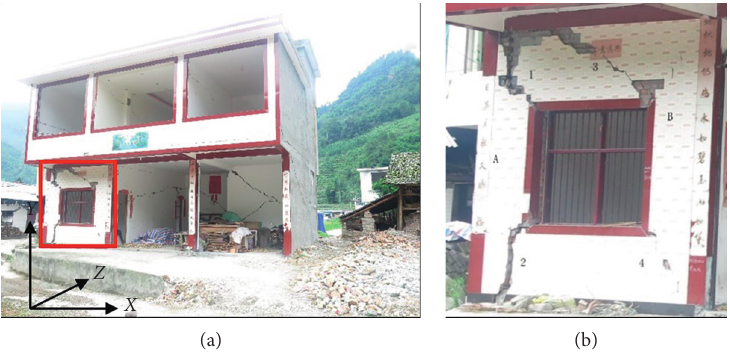
Figure 9: Brick and concrete buildings.